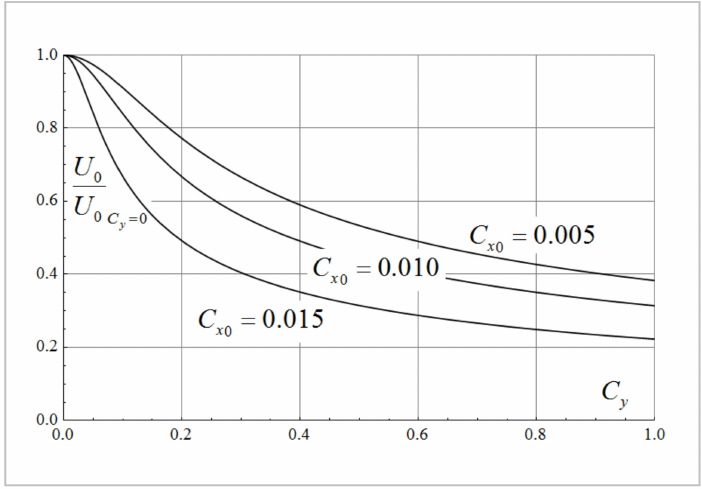
Figure 3. Speed on trajectory of the UG, related to the speed of vertical descent/ascent, plotted versus the lift